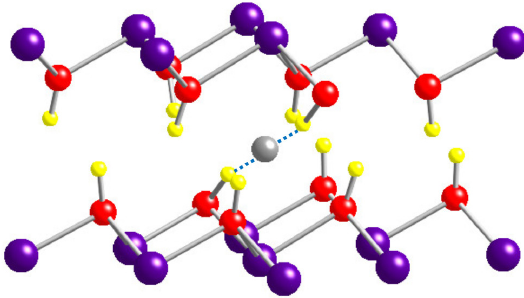
Figure 7. Atomic structure around interlayer C.